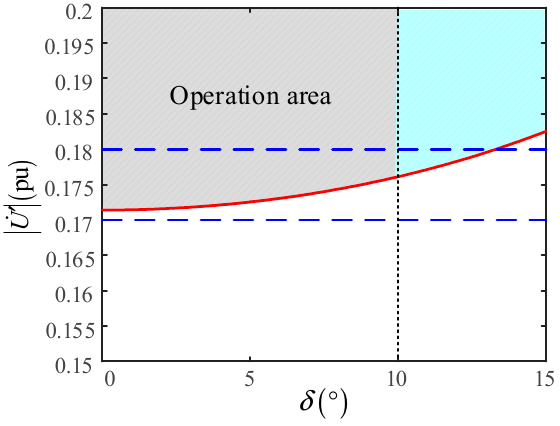
Figure 7. Operation range of terminal voltage of a VSC-based renewable energy during faults. Phase difference between internal potential and terminal voltage is generally smaller than 10 ◦ , when the terminal voltage falls to 0.18 pu, blue line is located in operation range of terminal voltage, and VSC-based renewable energy maintains fault ride-through operation. However, when terminal voltage fails to 0.17 pu, the fault voltage is outside shadow area and it is lower than critical voltage, which results in inverter blocking, as shown in Figure 5c, and output current of VSC-based